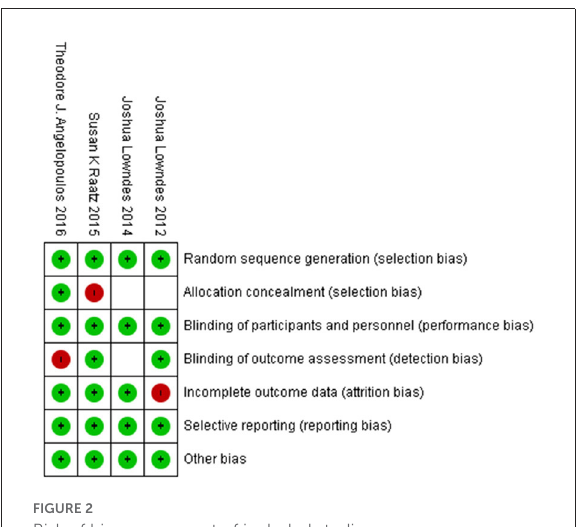
FIGURE2 Risk of bias assessment of included